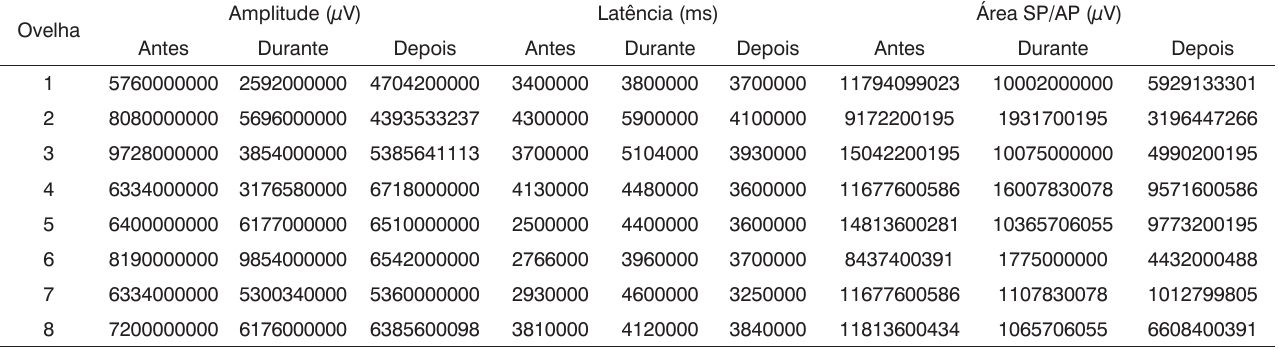
Tabela 1. Resultados dos registros dos potenciais evocados cocleares em oito ovelhas, com medidas da amplitude, latência e área SP/AP antes, durante e depois do procedimento.